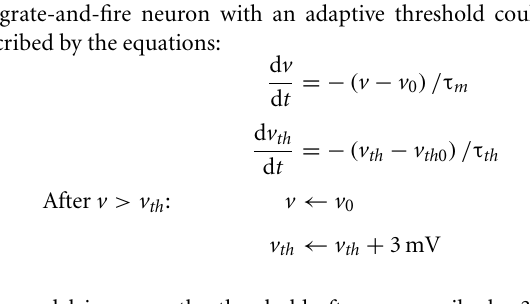
FIGURE 2 | Examples for refractoriness formulations in Brian2. (A,B) Refractoriness condition based on time since last spike. (C) Refractoriness condition based on membrane potential threshold